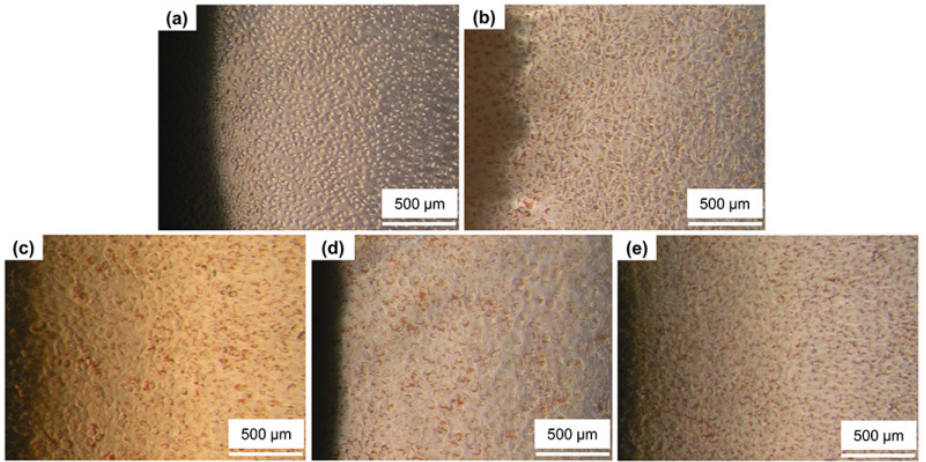
Figure 12. Morphology of L929 cells around the test specimens (100×): ( a ) positive control (rubber latex); ( b ) negative control (high-density polyethylene (HDPE)), ( c ) as-cast alloy, ( d ) PVD-coated alloy, and ( e ) CVD-coated alloy.